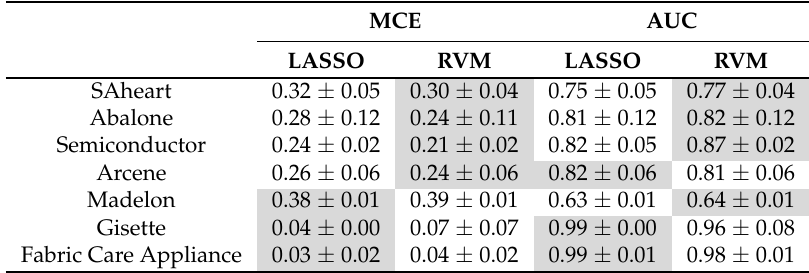
Table 4. Mean and standard deviation of the MCE and the AUC distributions obtained from the MC analysis for real datasets. The lower the MCE and the higher the AUC values the better in term of accuracy. MCE AUC